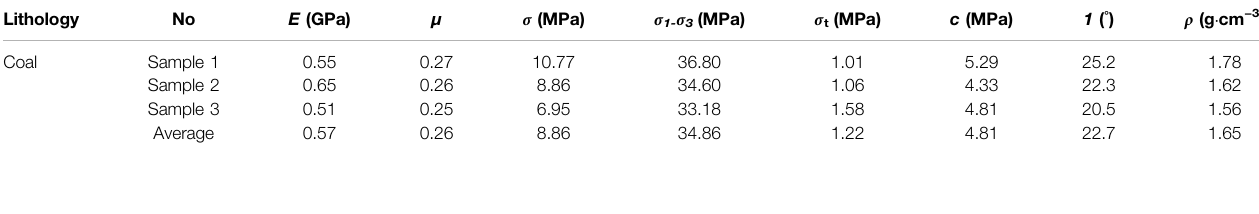
TABLE 1 | Physical and mechanical parameters of coal